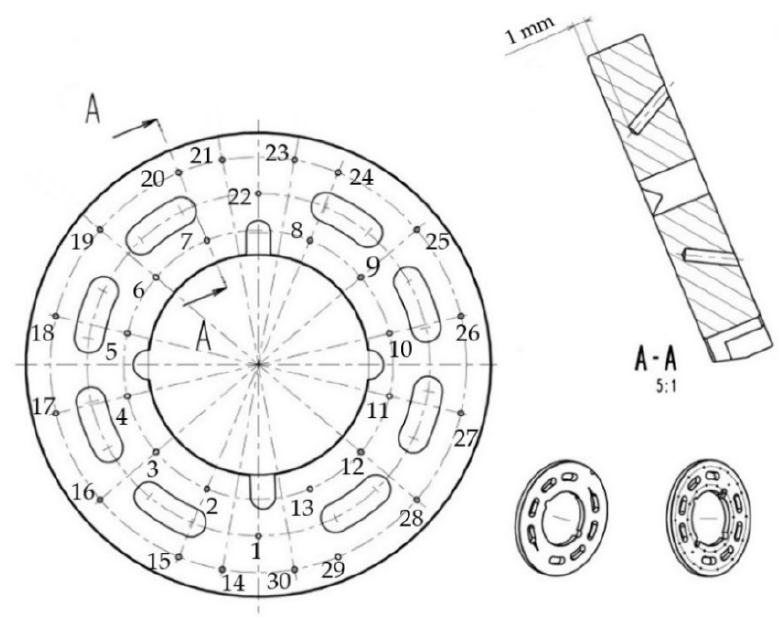
Figure 8. Position of the thermocouples in the valve plate.